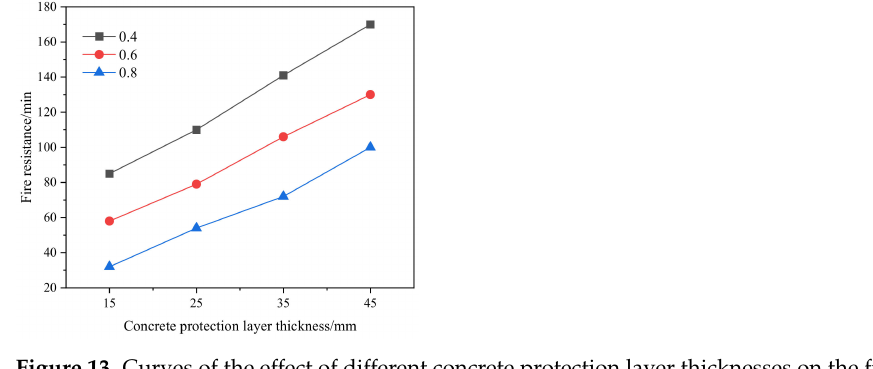
Figure 13. Curves of the effect of different concrete protection layer thicknesses on the fire resistance of T-beams.